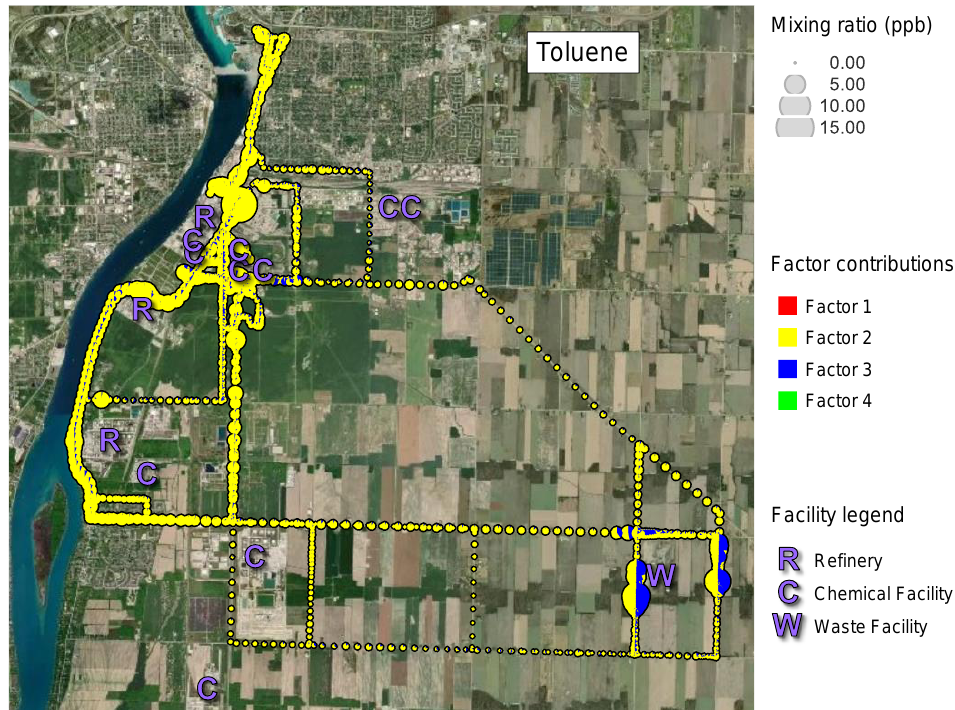
Figure 6. Contributions of each of the four local factors to toluene mixing ratios as a function of measurement location while mobile. The diameter of each pie denotes the toluene mixing ratio and the size of each wedge within each pie represents the relative contribution of each factor for that measurement period.